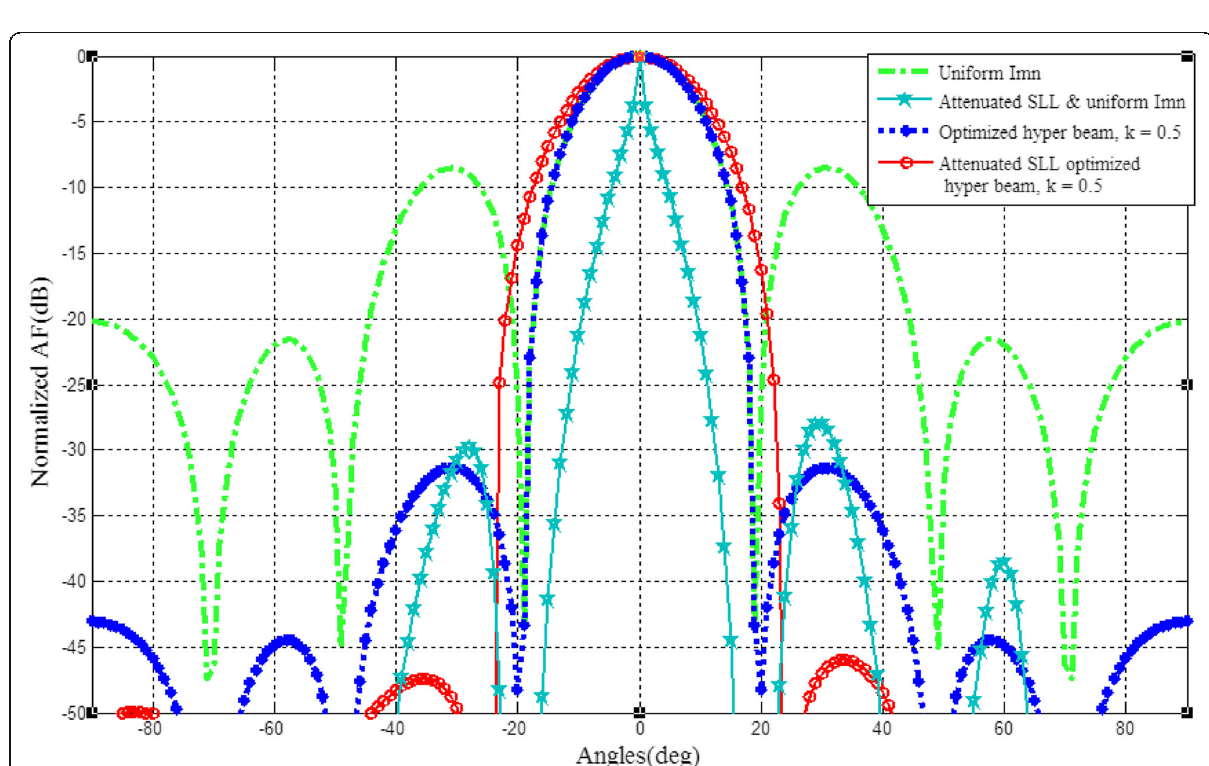
Fig. 5 Comparison of attenuated SLL over uniform and optimized excitation weights